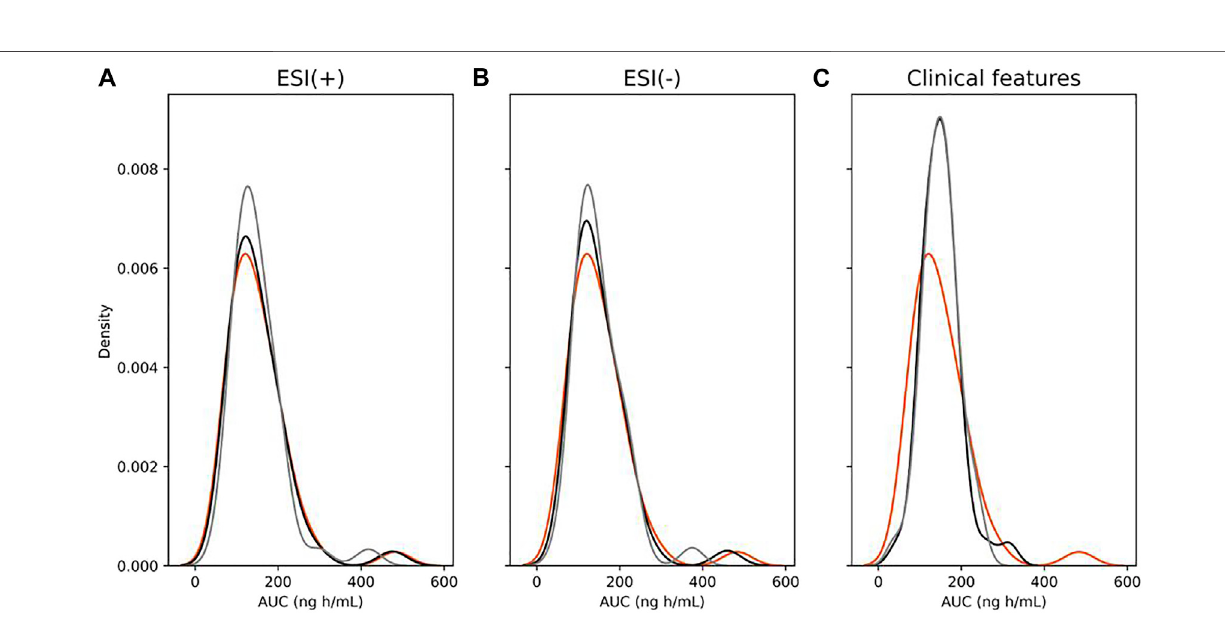
frequency plots. Results demonstrate that the clinical feature model generates an evidently higher difference in the distance of both training and LOOCv testing frequencies of predicted values from true values compared to the same measure of both the ESI (+) and ESI ( − ) models, showing its considerably lower predictive ability compared to information provided by metabolomics.